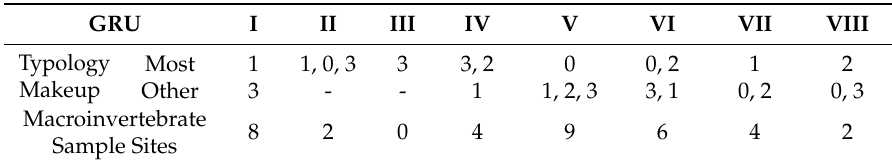
Table 3. Summary of typology makeup, and the number of macroinvertebrate samples contained within each GRU.